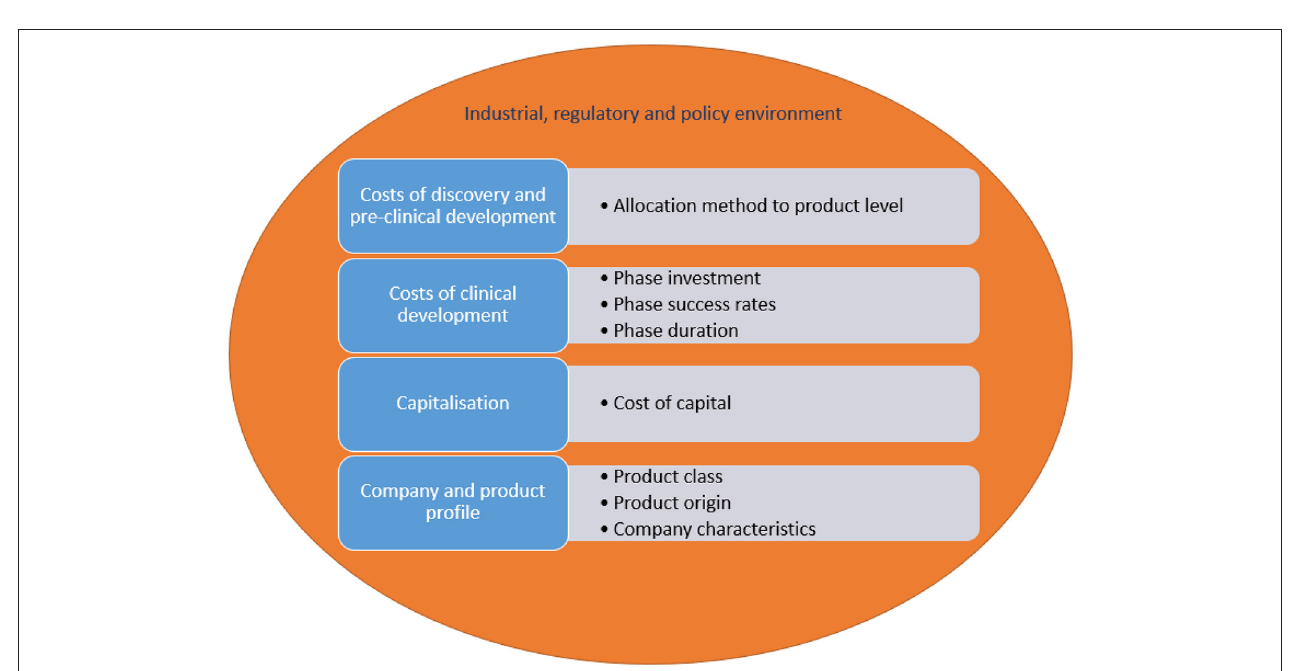
FIGURE 4 | Drivers of R&D costs of new medicines and how these are impacted.